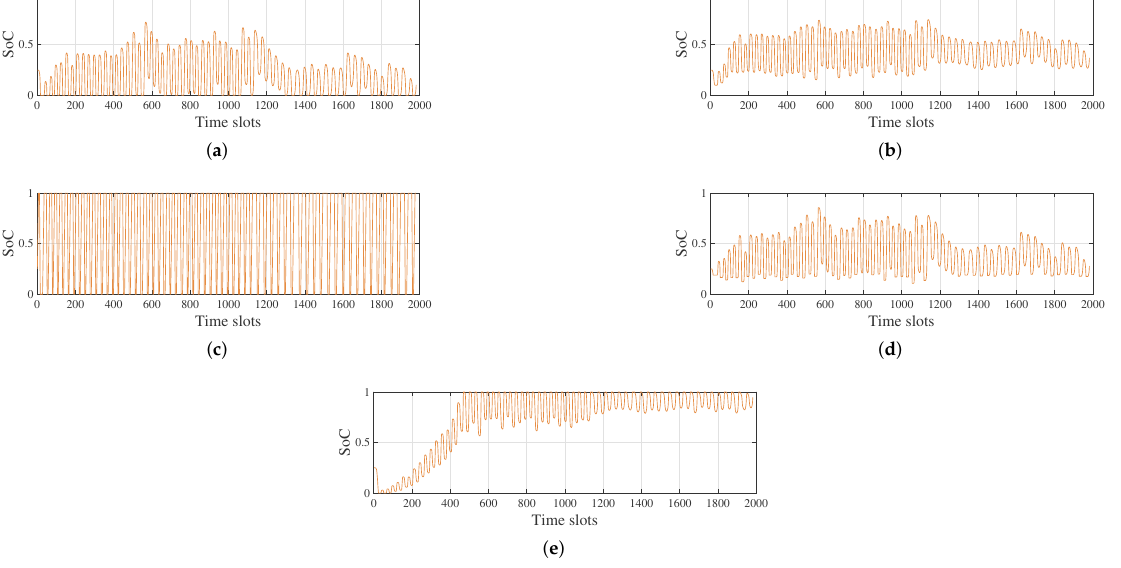
Figure 8. Battery SoC profile for the five considered strategies: ( a ) ElCo; ( b ) BaCo; ( c ) SmChCo; ( d ) BoCo; ( e )